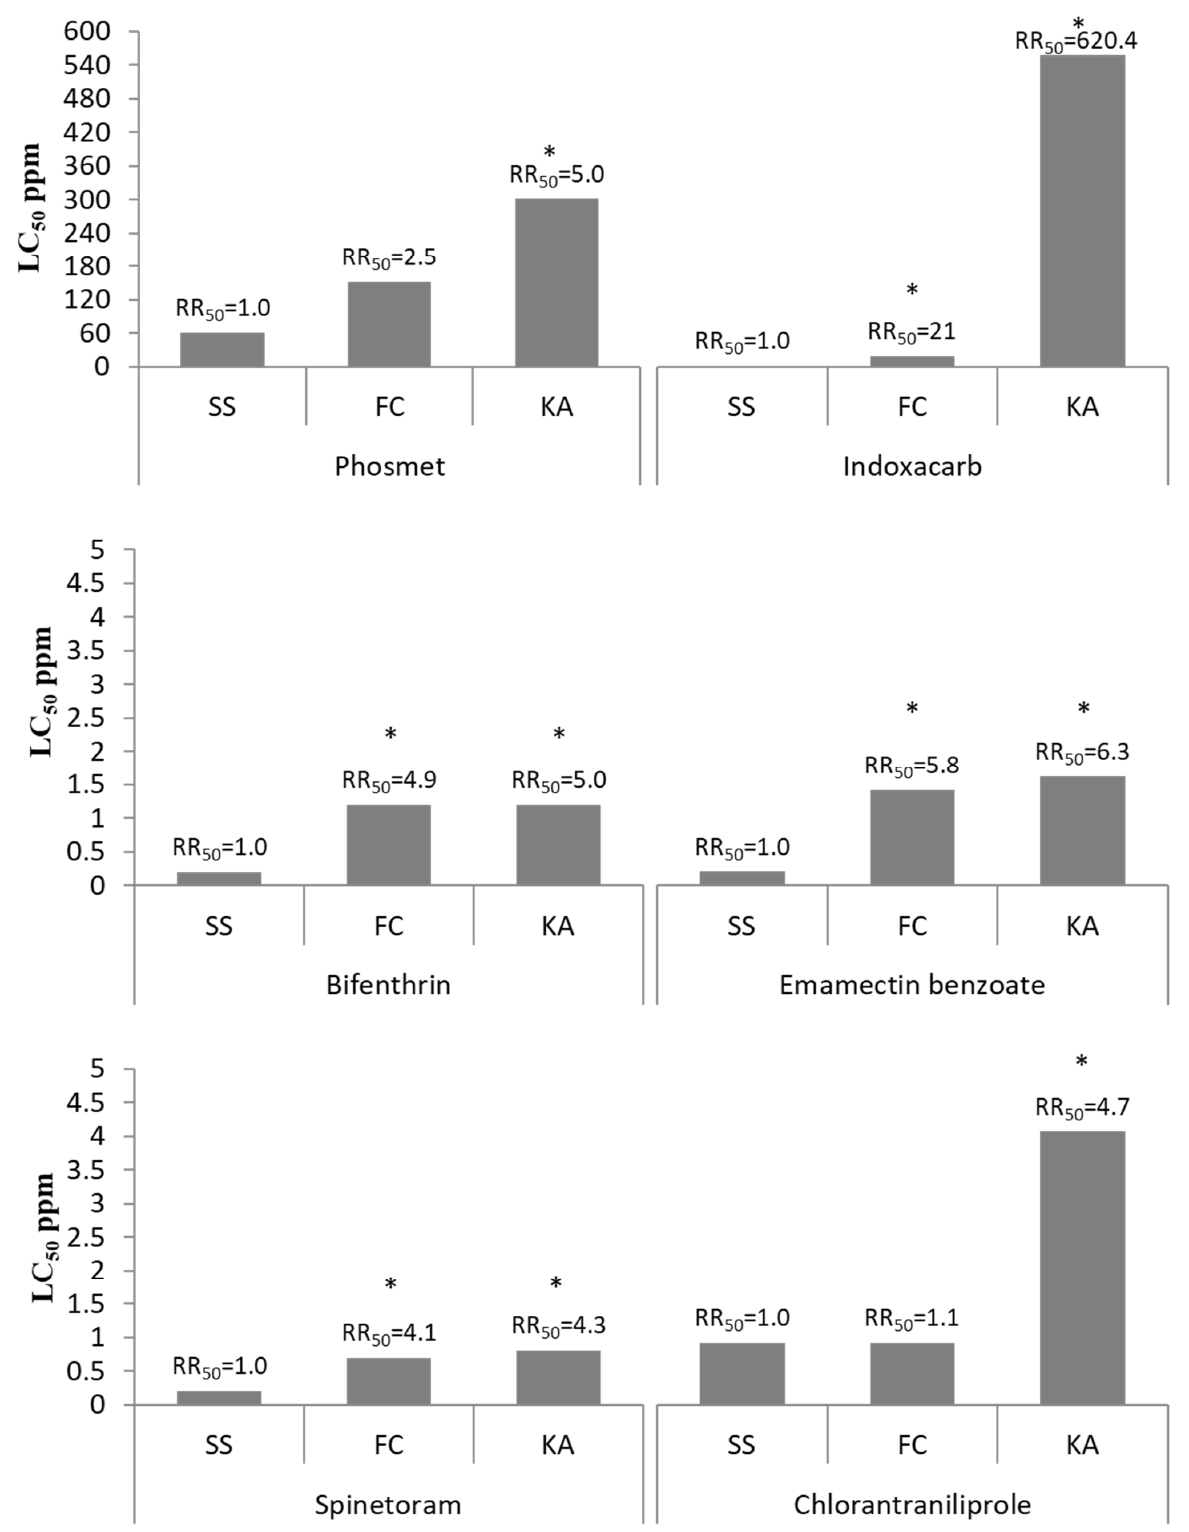
Figure 1. The baseline toxicity study of Hafez et al. [1] of the tested insecticides in the current study on 12–24 h-old C. rosaceana larvae of two field strains, namely, apple (KA) and cherry (FC), compared to a susceptible strain (SS). LC 50 = median lethal concentration. PPM = part per million. Resistance ratio 50 (RR 50 ) = LC 50 value of the field strain/LC 50 value of the susceptible strain. An asterisk (*) means the field strain is significantly more resistant than the susceptible